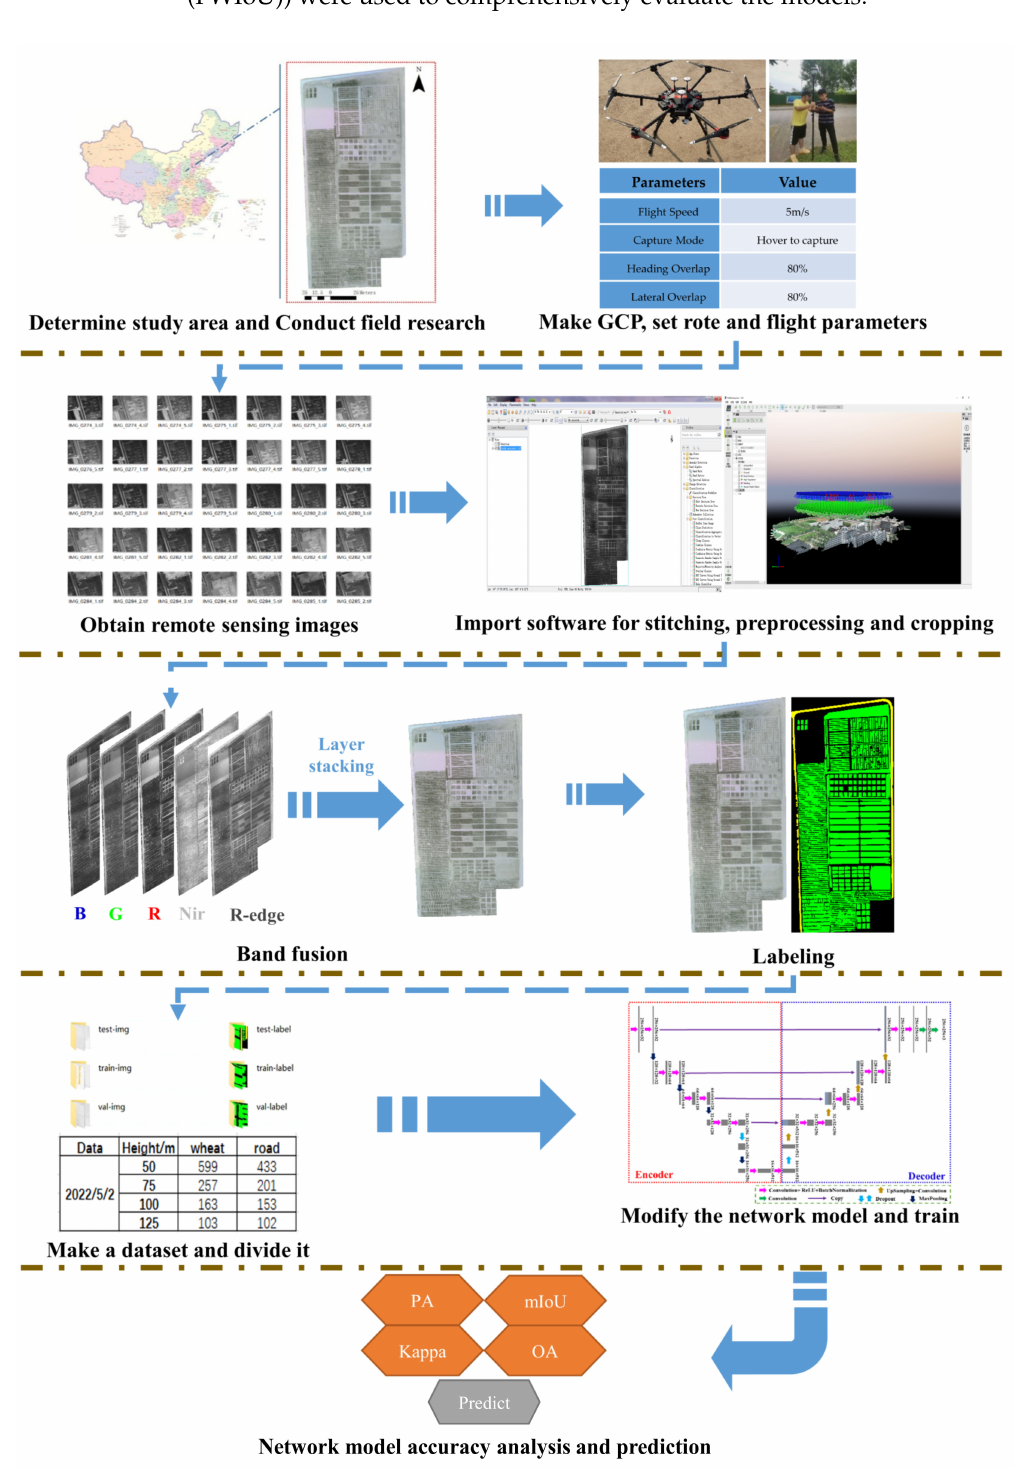
Figure 1. Workflow of complex wheat field classification research based on multi-scale feature